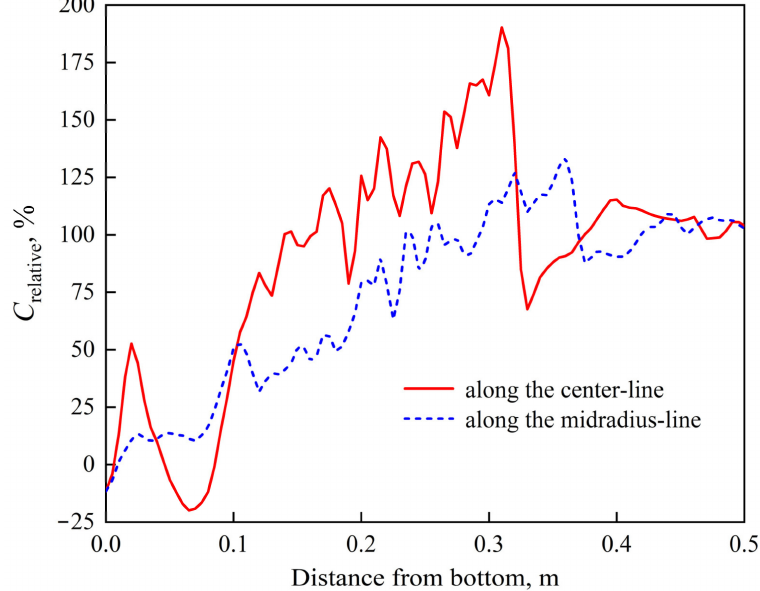
Figure 14. Variation of relative segregation ratio along the centerline and midradius-line after